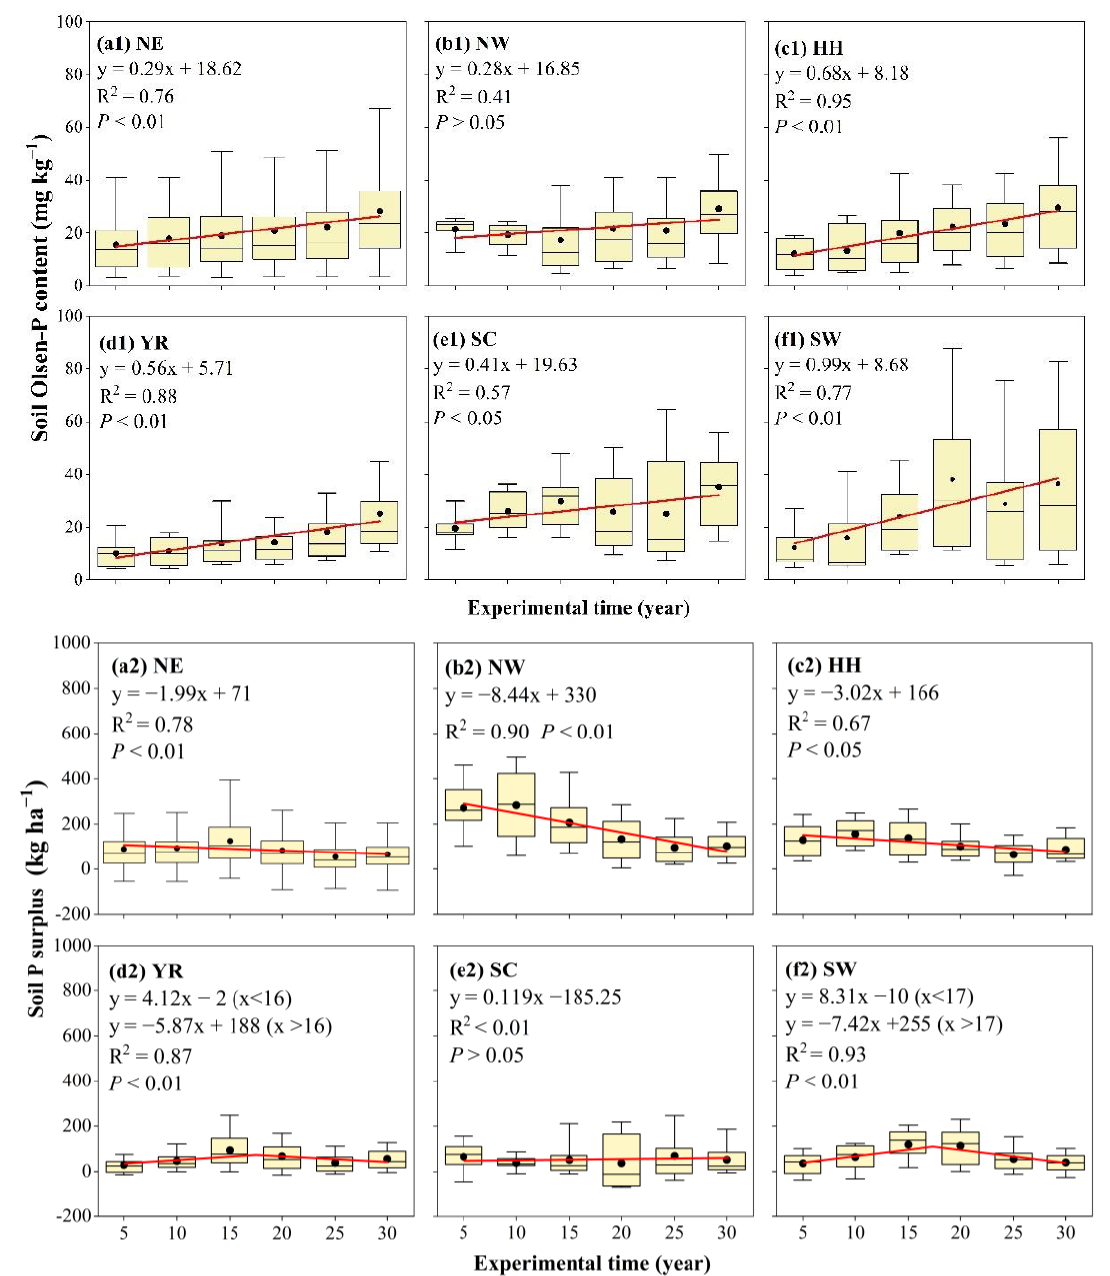
Figure 3. The temporal-spatial patterns of soil Olsen-P content and apparent soil P surplus across Chinese cropping systems from 1988 to 2018. Regional abbreviations are as in Figure 1. Probability levels < 0.05 were considered as statistically significant.